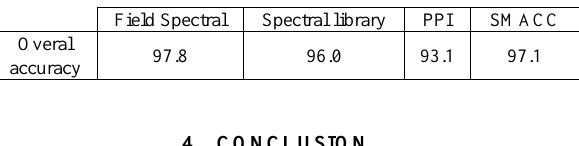
Table 1. The overall accuracy of